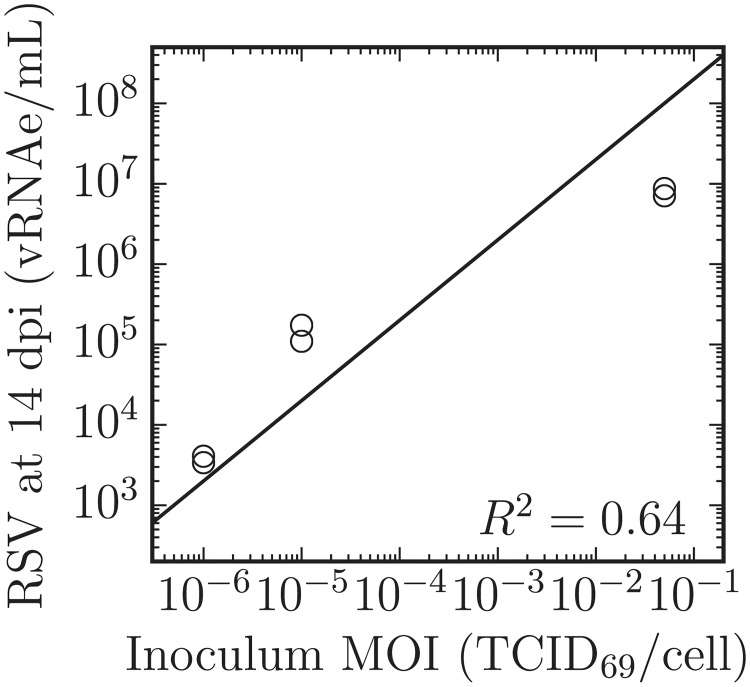
Total RSV production is proportional to the inoculum MOI.The concentration of total RSV in the supernatant quantified via qRT-PCR (vRNAe/mL) at 14 dpi for infections performed in duplicate is shown as a function of the MOI of the inoculum deposited onto the SIAT cells (TCID69/cell). The relation shown (solid line) corresponds to log10(y) = log10(x) + b where b = 9.3 ± 0.8 and R2 is as shown. The total number of RSV progeny produced over the course of the infections is approximately proportional to inoculating MOI. Duplicate measures (two symbols) rather than error bars are plotted at each sampling time point, through in some cases only one point is visible.